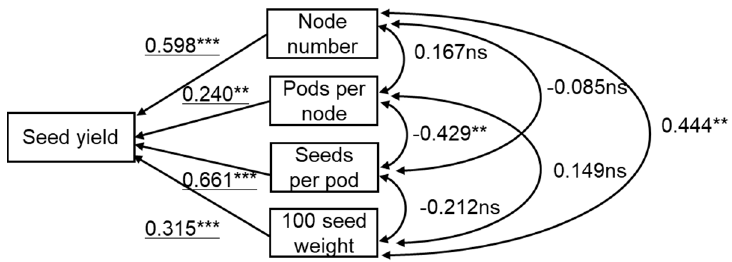
Figure 2. Diagram showing the regression coefficients of yield components in the multiple regression on seed yield and the coefficients of correlations between variables obtained across two years and three cultivars in the Tohoku region of northern Japan. Because the nature of the relationship between yield and yield components was multiplicative, the data of all cultivars in each block ( n = 36) were natural-log transformed. Values with the single-headed arrows are the standardized multiple regression coefficients, and those with double-headed arrows are Pearson’s correlation coefficients. *** p < 0.001; ** p < 0.01; ns, not significant.